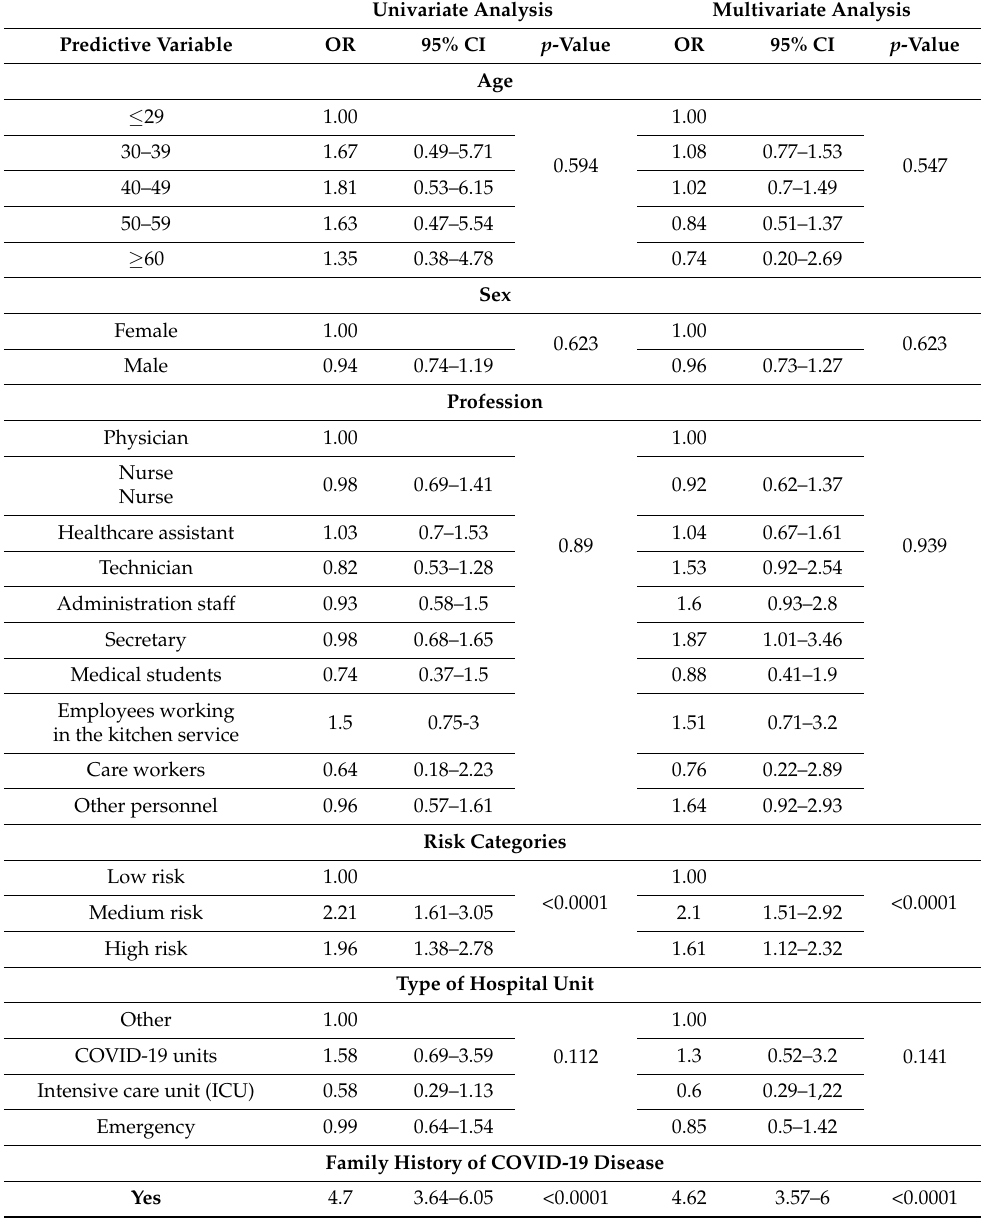
Table 2. Univariate and multivariate analyses for risk factors for SARS-CoV-2 seropositivity of HCWs. Univariate Analysis Multivariate Analysis Predictive